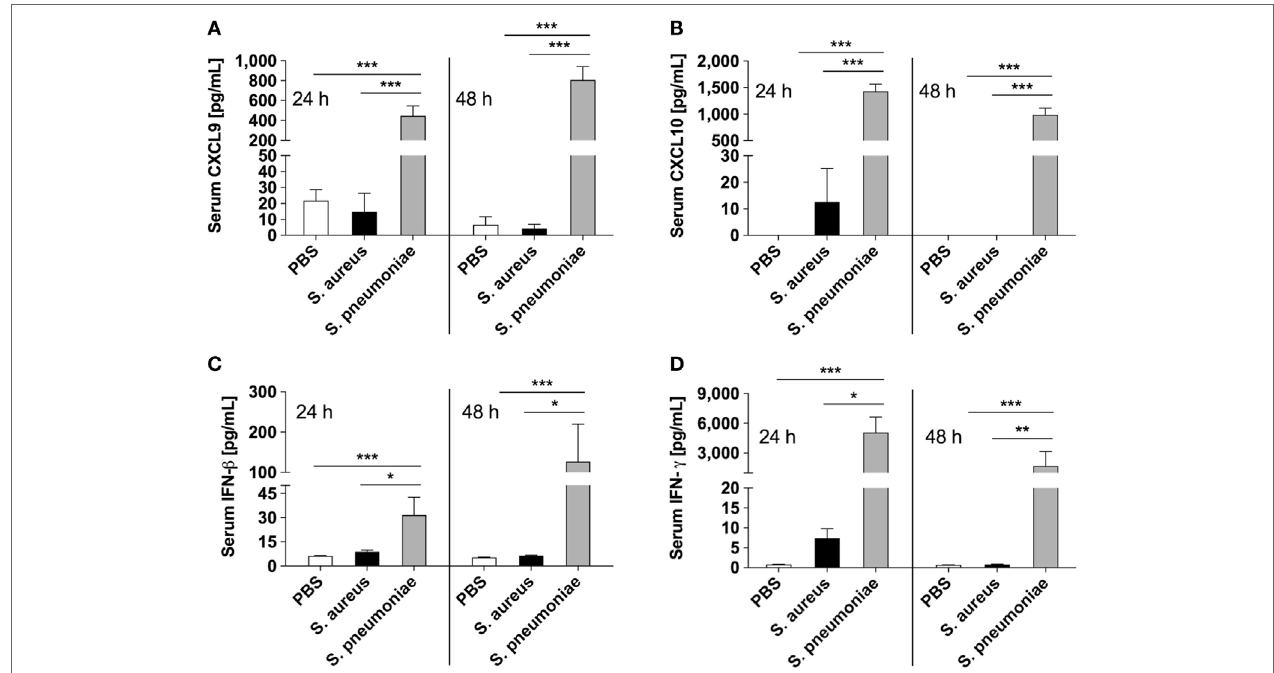
FigUre 4 | Circulating levels of interferons and interferon-induced mediators in infected mice. Serum levels of CXCL9 (a) , CXCL10 (B) , IFN- β (c) , and IFN- γ (D) in Streptococcus pneumoniae- infected (gray bars), Staphylococcus aureus- infected (black bars), or PBS-treated (white bars) mice measured with bead-based multiplex immunoassay at 24 and 48 h after intranasal inoculation. Each bar represents the mean ± SD of values obtained from eight to nine mice from three independent experiments. * p < 0.05; ** p < 0.01; *** p <